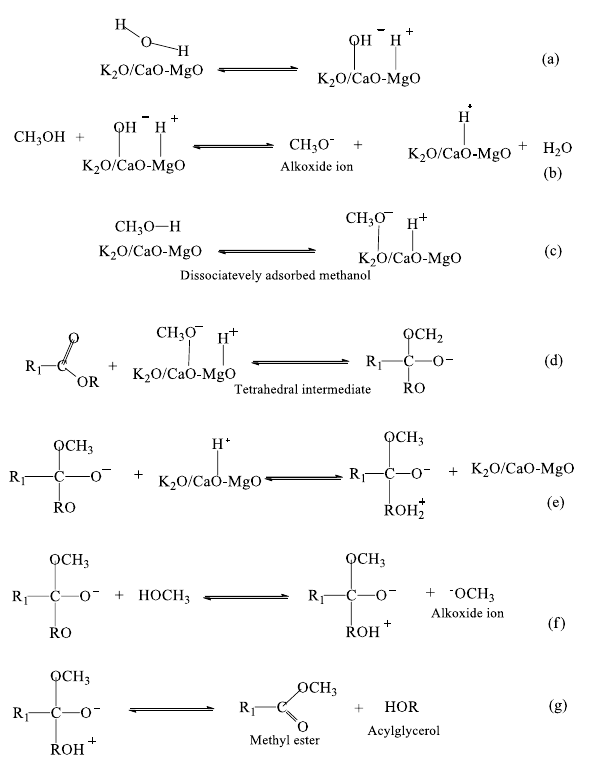
Figure 2. Mechanism of solid base catalyst ( a ) Surface OH - formed on K 2 O / CaO-MgO ( b ) CH 3 O - and H 2 O formed ( c ) CH 3 OH adsorb separately on K 2 O / CaO-MgO ( d ) Intermediate formed ( e ) Intermediate subsequently protonated ( f ) Intermediate react with methanol ( g ) Rearrangement of tetrahedral result in the formation of methyl ester and glycerol